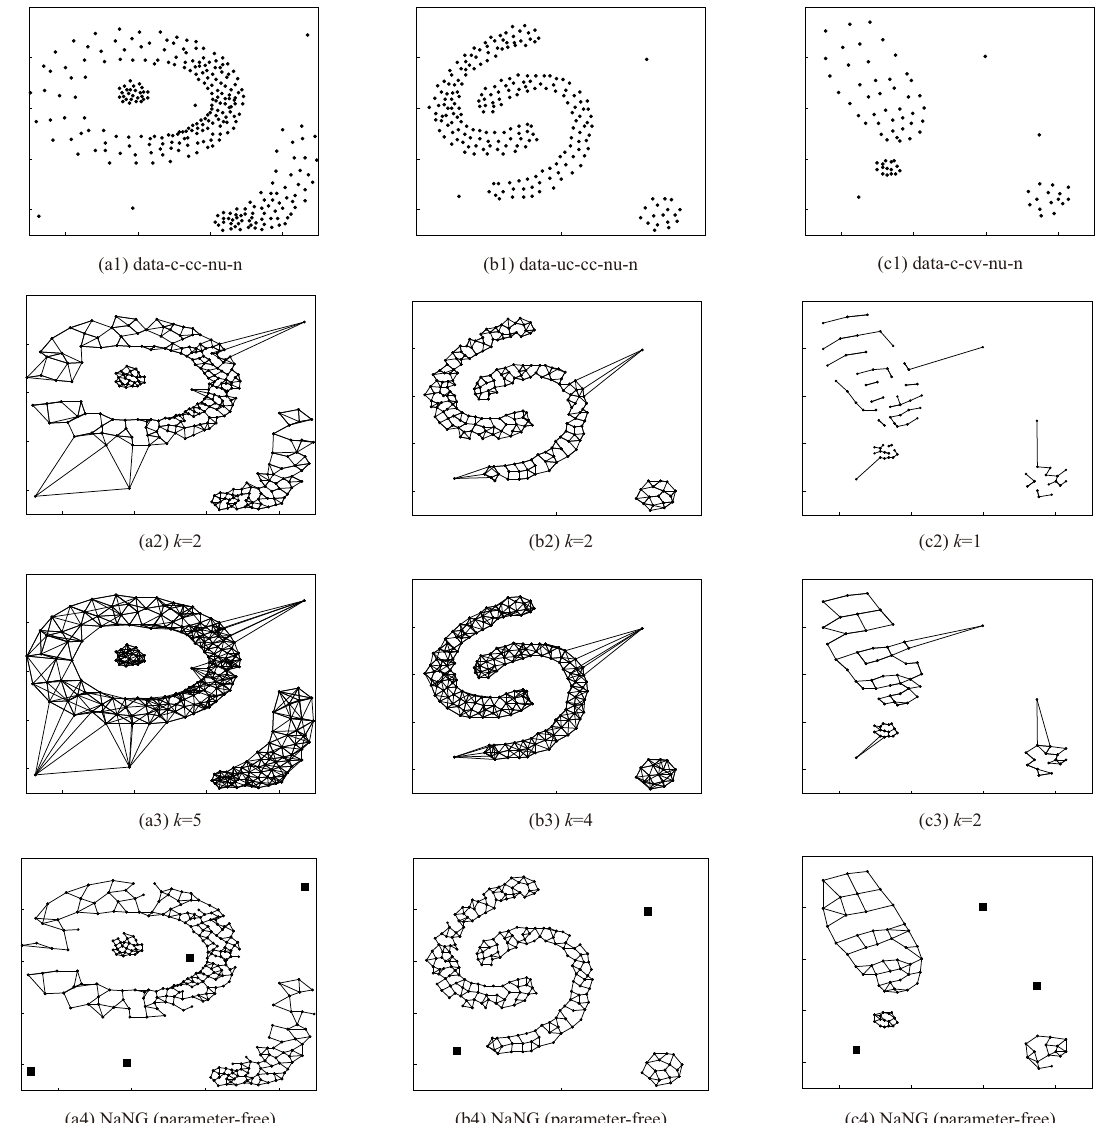
Fig. 2 Neighborhood graphs of KNN with different k and NaN with no parameter (line 4). NaN can maintain the basic shape of data, and the neighbor number of each point is the